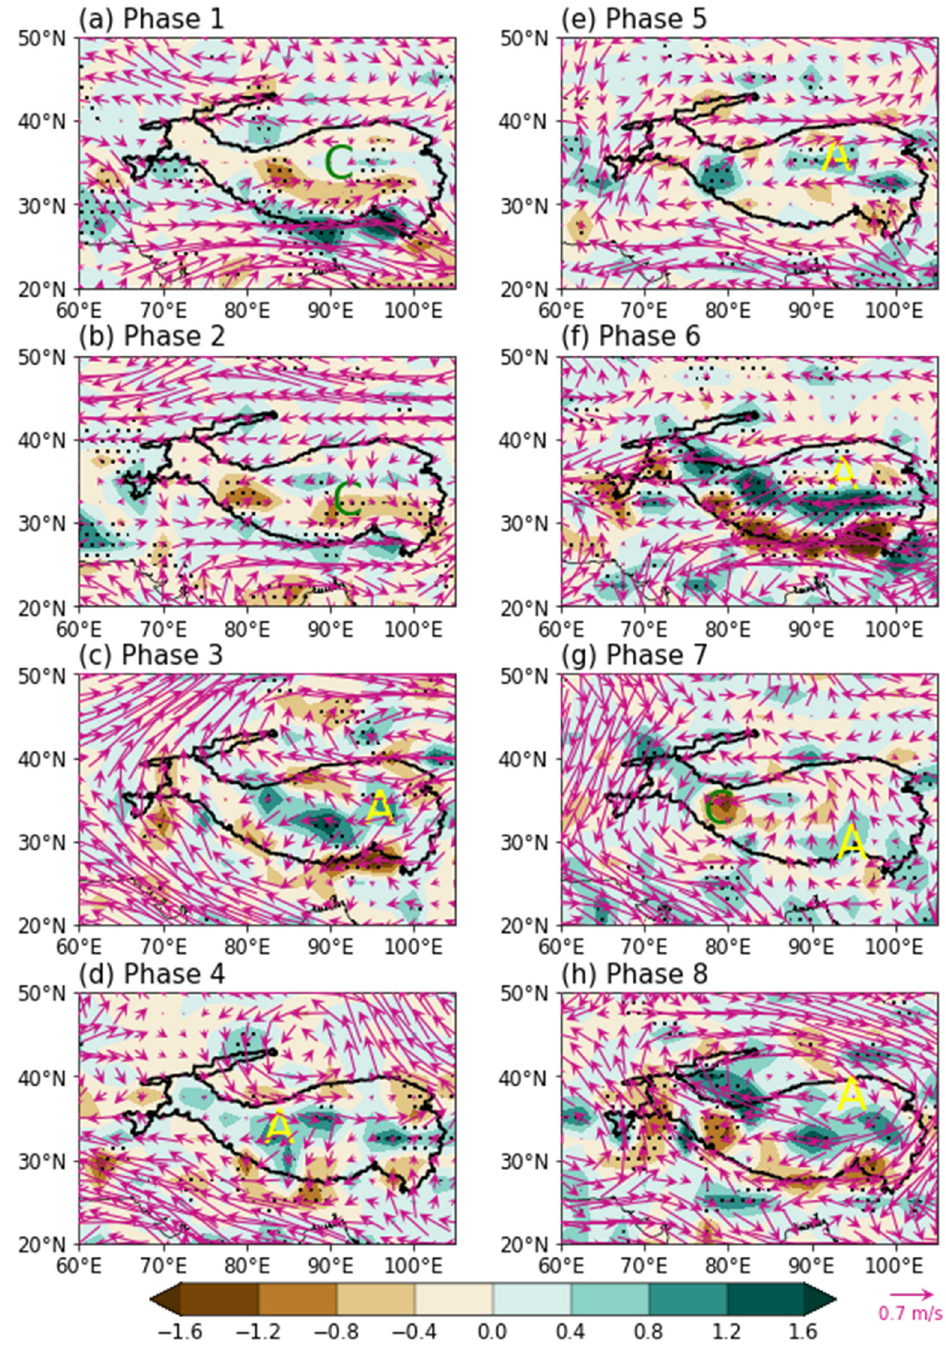
Figure 8. Composite patterns of the 500 hPa divergence (shading; 10 − 6 s − 1 ) and horizontal wind (vectors; m/s) anomalies in MJO Phases 1 ‒ 8 ( a ‒ h ). The dots indicate that values are statistically significant at the 95% confidence level. The notations with C and A indicate anomalous cyclone and anticyclone, respectively.